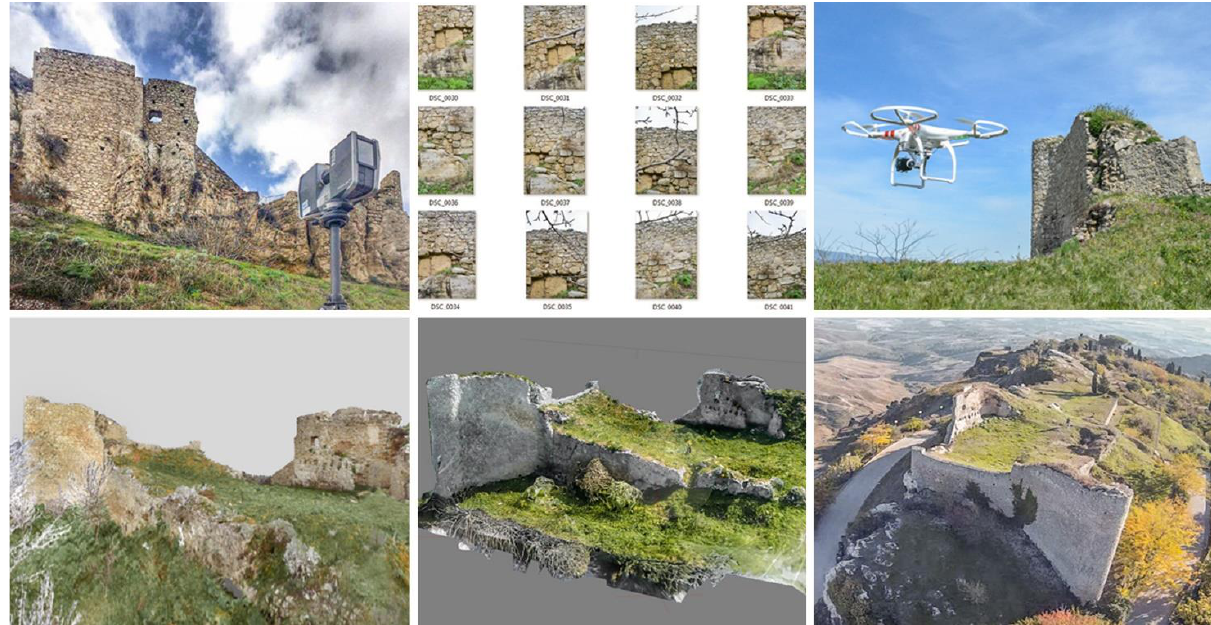
Figure 3. The integrated survey: 3D laser scanning and digital terrestrial and UAV